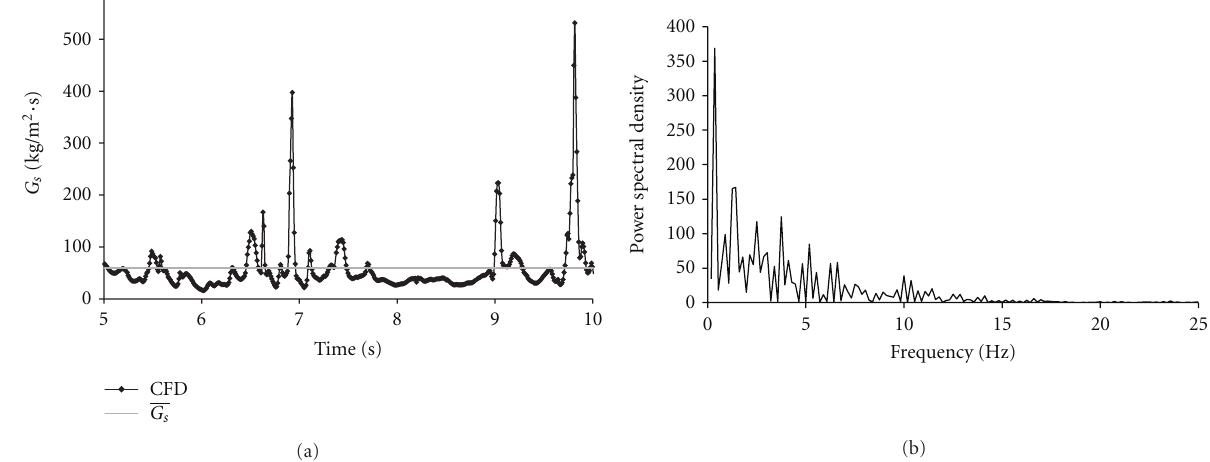
Figure 4: CFD simulation results of solid phase mass flux leaving the riser: (a) time history fluctuations and (b) power spectral density.